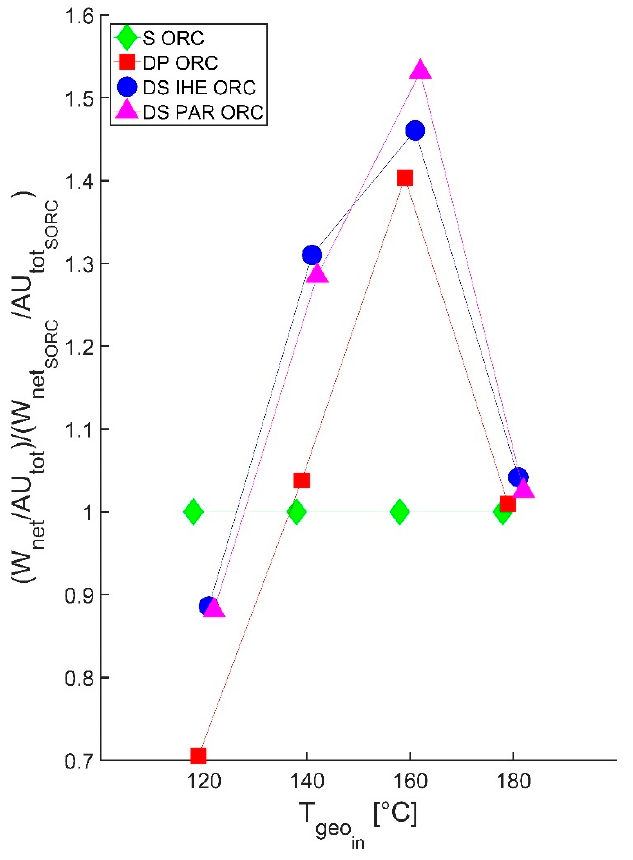
Figure 12. The comparison of (𝑊 (cid:3041)(cid:3032)(cid:3047) /𝐴𝑈 (cid:3047)(cid:3042)(cid:3047) )/(𝑊 (cid:3041)(cid:3032)(cid:3047)(cid:2879)(cid:3020)(cid:3016)(cid:3019)(cid:3004) /𝐴𝑈 (cid:3047)(cid:3042)(cid:3047)(cid:2879)(cid:3020)(cid:3016)(cid:3019)(cid:3004) ) values for the considered con- Figure 12. Thecomparisonof ( W net / AU tot ) / ( W net − SORC / AU tot − SORC ) figurations.